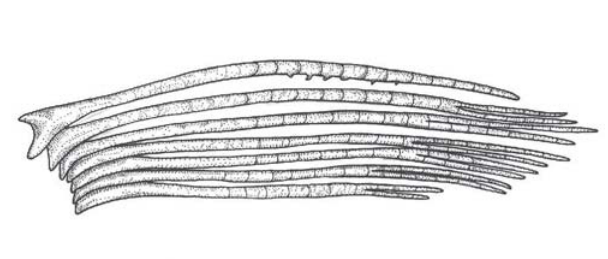
Fig. 7. Lophiobrycon weitzmani , paratype, adult male, LIRP 4338, 33.1 mm SL; pelvic-fin rays, ventral view, left side, anterior at left.